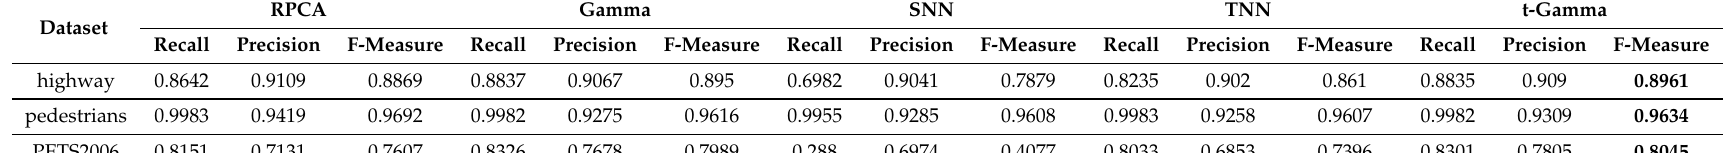
Table 2. Quantitative Evaluation for algorithm on CDNet Datasets